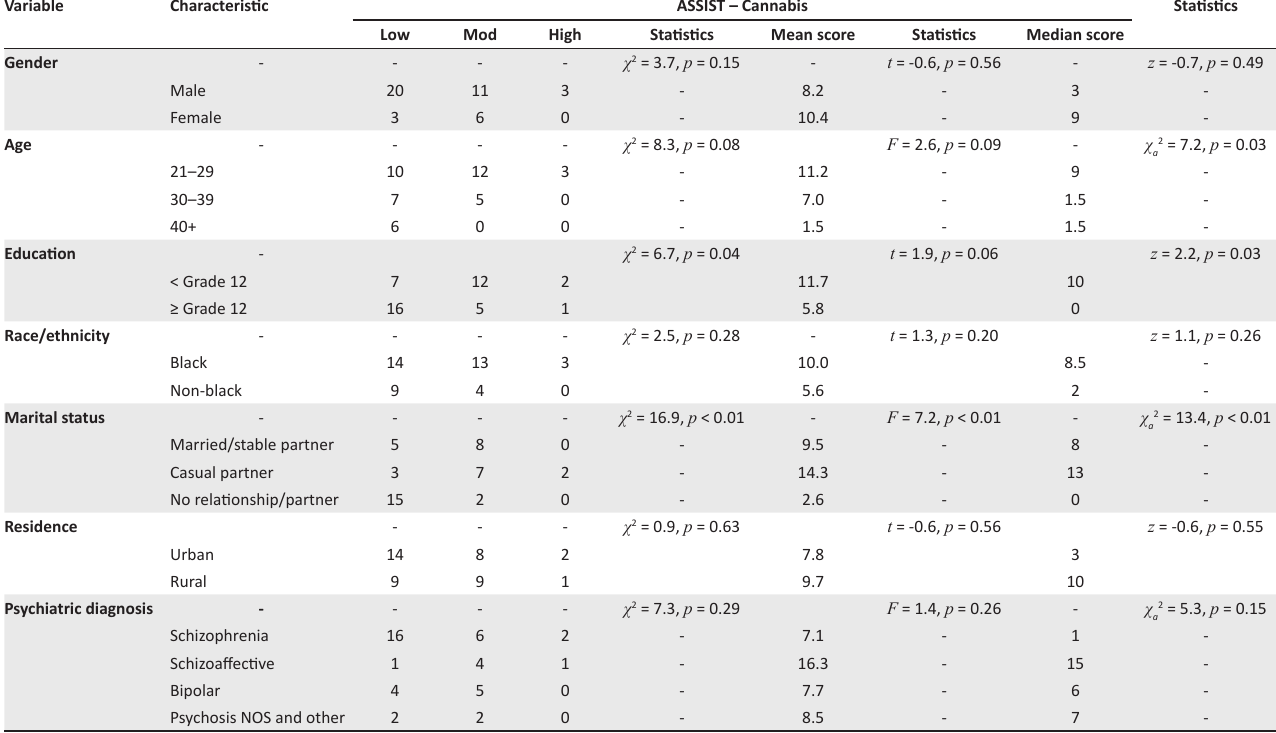
TABLE 3: Bivariate analysis between ASSIST risk score (lifetime and recent cannabis use) and demographic/clinical characteristics ( n = 87).